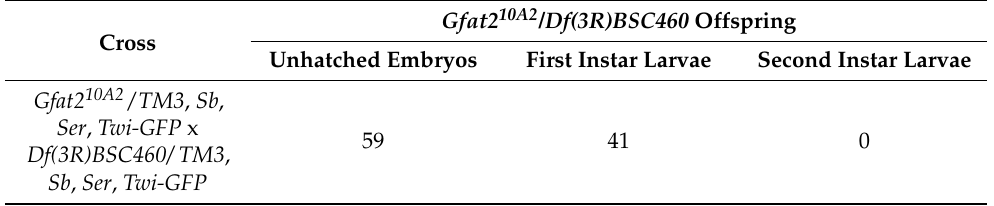
Table 1. Lethal phase analysis of a Gfat2